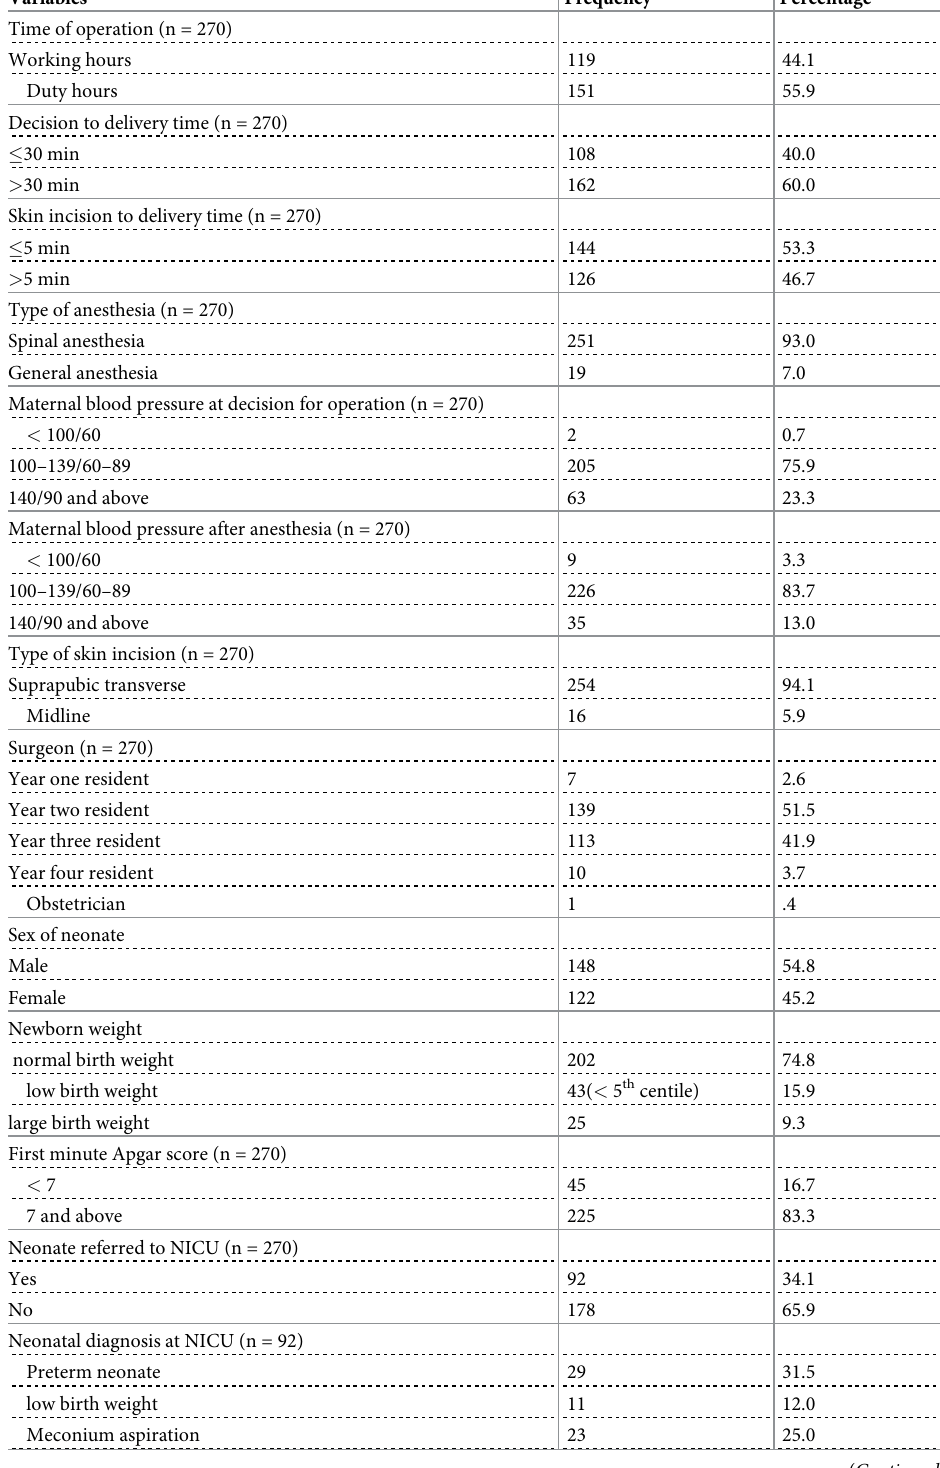
Table 4. Intraoperative characteristics and neonatal outcomes of participants in Hawassa University comprehen- sive specialized hospital, Southern Ethiopia,